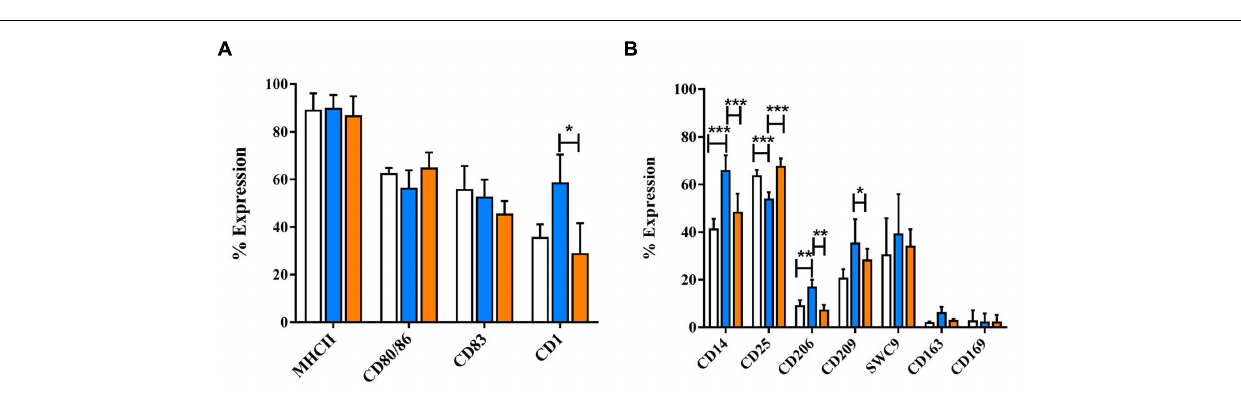
FIGURE 6 | The effects of dexamethasone and IL-10 treatment on the phenotype of porcine MoDCs. Four-day-old MoDCs were treated with either dexamethasone or IL-10 for 24 h before surface staining with various anti-porcine or anti-human mono/poly-clonal antibodies for flow cytometric analysis of surface molecules involved in antigen presentation and maturation (A) or against other co-stimulatory molecules and myeloid lineage markers (B) in untreated MoDCs (unfilled bars), dexa treated MoDCs (blue bars), or IL-10 treated MoDCs (orange bars). Bars show mean percentage of cells expressing each marker + SD (A,B) . One-way ANOVA was used to assess significance followed by Bonferroni’s multiple comparison test ∗∗∗ p < 0.0001, ∗∗ p < 0.001, ∗ p <